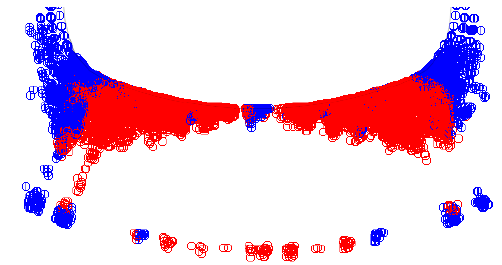
Figure 14. Plastic zone of the original scheme.